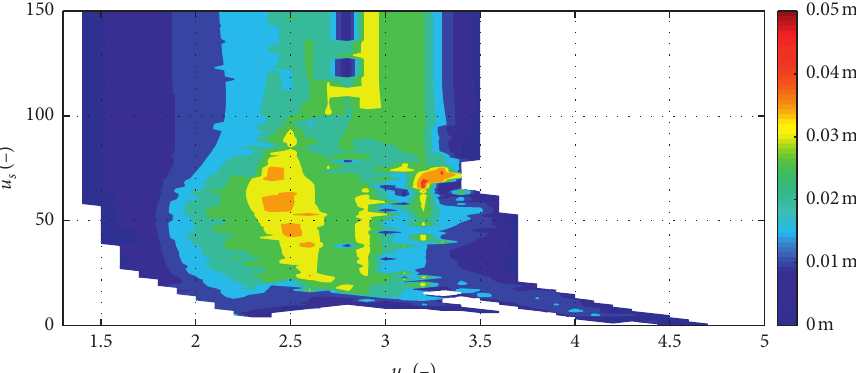
Figure 12: The maximal allowable ground disturbance as a function of the input signals u 0 . 048 m at u e � 3 . 1and u s �